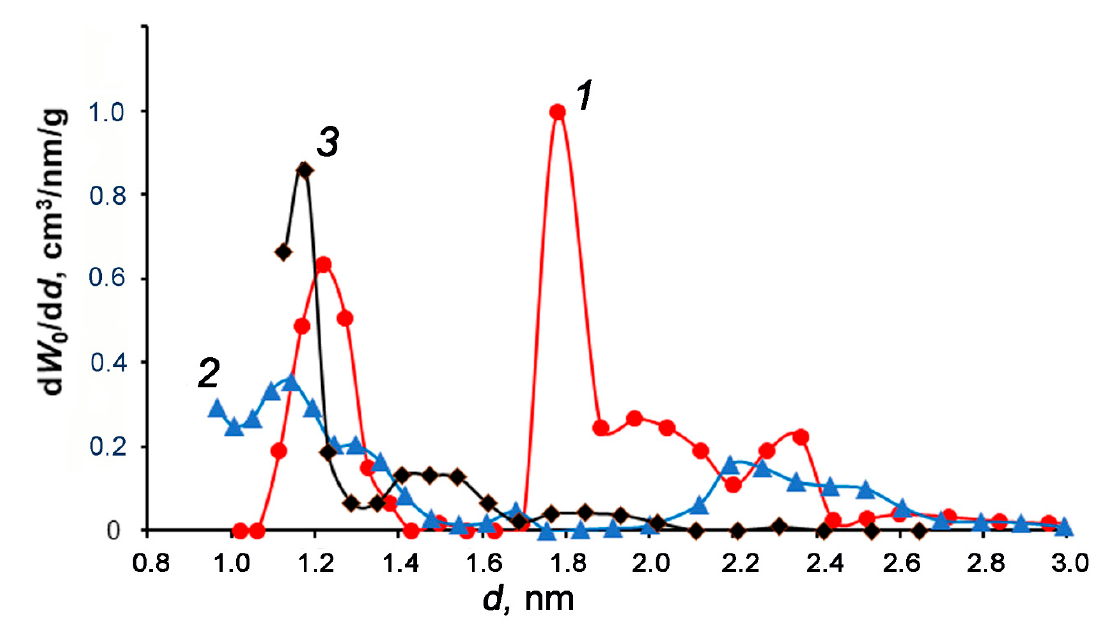
Figure 4. The pore size distribution of AC-90S (1), AC-90L (2), and AC-60L (3) calculated by the non-local density functional theory (NLDFT) model for a combined slit + cylinder pore geometry from the nitrogen adsorption data at 77 K. Symbols correspond to experimental data; solid lines are spline- approximation.